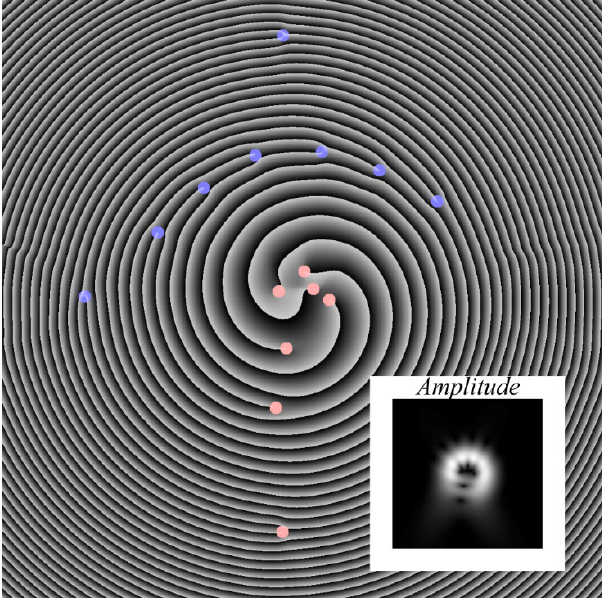
Figure 6. Amplitude (inset) and phase of light field (14) after passing through aperture (15) with the angle α = 150° at a distance of z = 20 μ m. Positive dislocations are purple shaded circles and negative ones are within cyan shaded circles. Both amplitude and phase field sizes are 48 × 48 μ m.